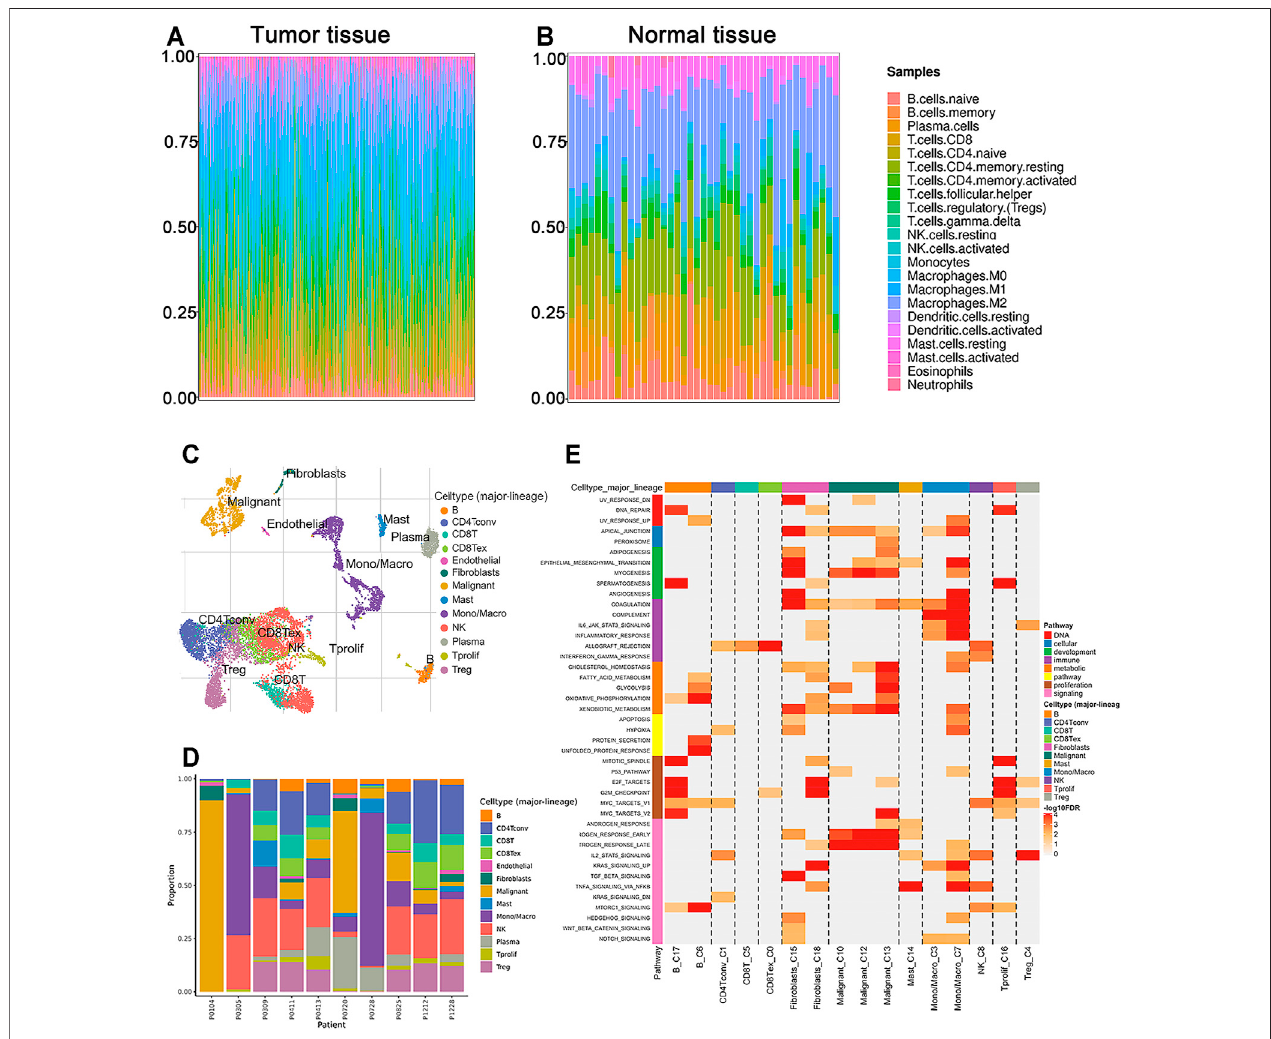
FIGURE 4 | The proportions of TIICs in TME and enrichment analysis by GSEA. (A,B) Composition of 22 immune cells in the tumor and normal tissues of CRC patients in TCGA cohort. (C,D) Components of TME at the single-cell resolution of CRC patients in GSE146771 cohort. (E) Enriched upregulated hallmark pathways in different immune